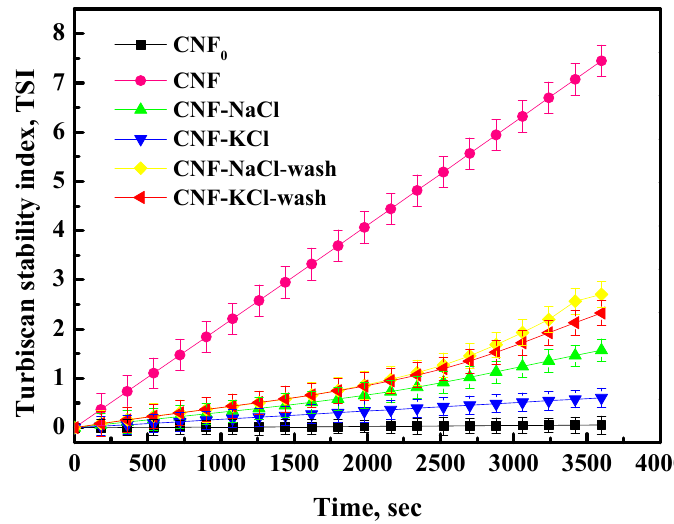
Figure 6. Turbiscan stability index of CNF samples.